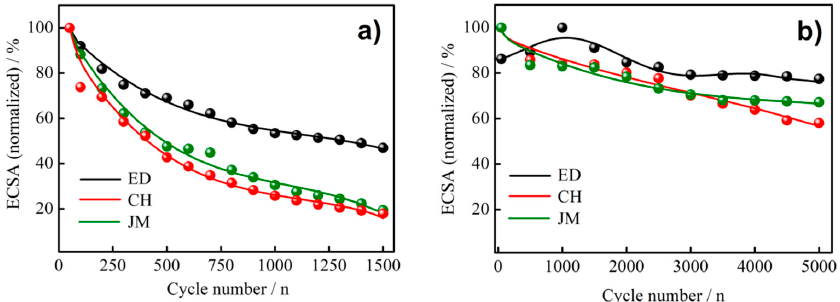
Figure 4. Figure 4. Stability of the Pt/C electrocatalysts as a function of the cyclic potential range: ( a ) 0.05–1.3 V vs. RHE; ( b ) 0.6–1.0 V vs. RHE.